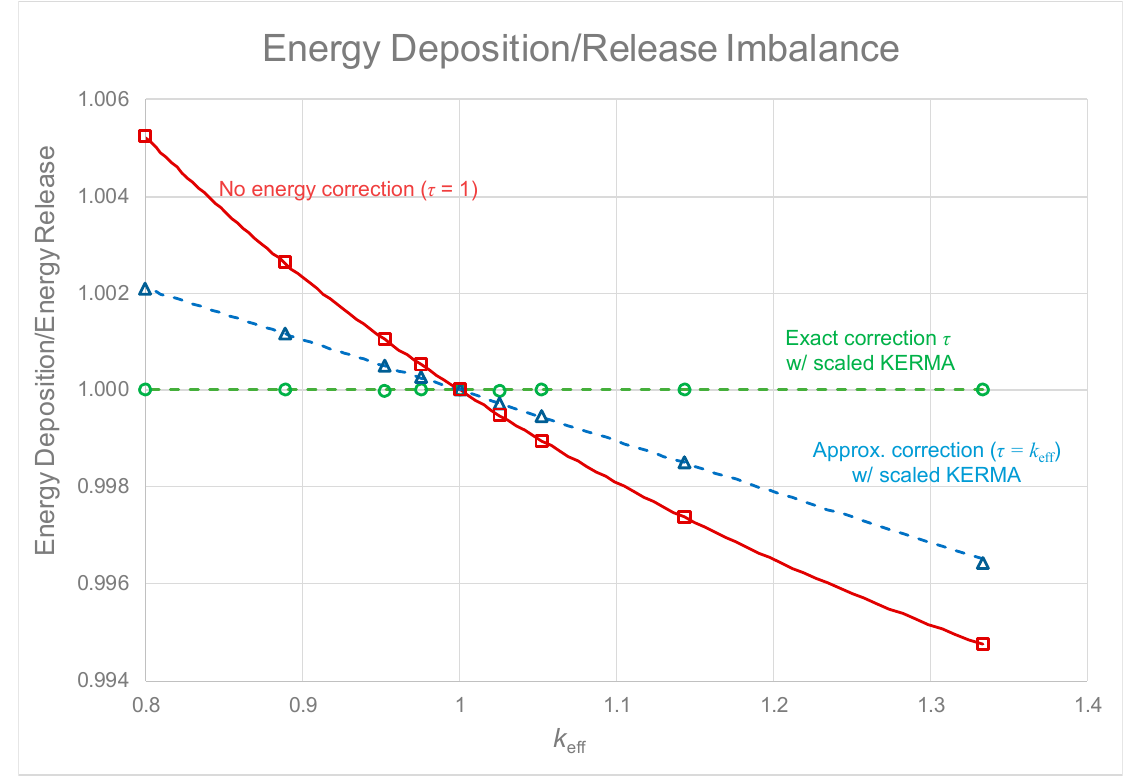
Figure 3. Energy deposition to release imbalance as a function of multiplication factor for an infinite, homogeneous, two-nuclide test problem. Theoretical results are provided for three energy correction schemes (no correction, approximate, and exact), and for reference (solid lines) and scaled KERMA values (dashed lines). Corresponding numerical results from an MC21 calculation are shown as open markers for selected conditions.